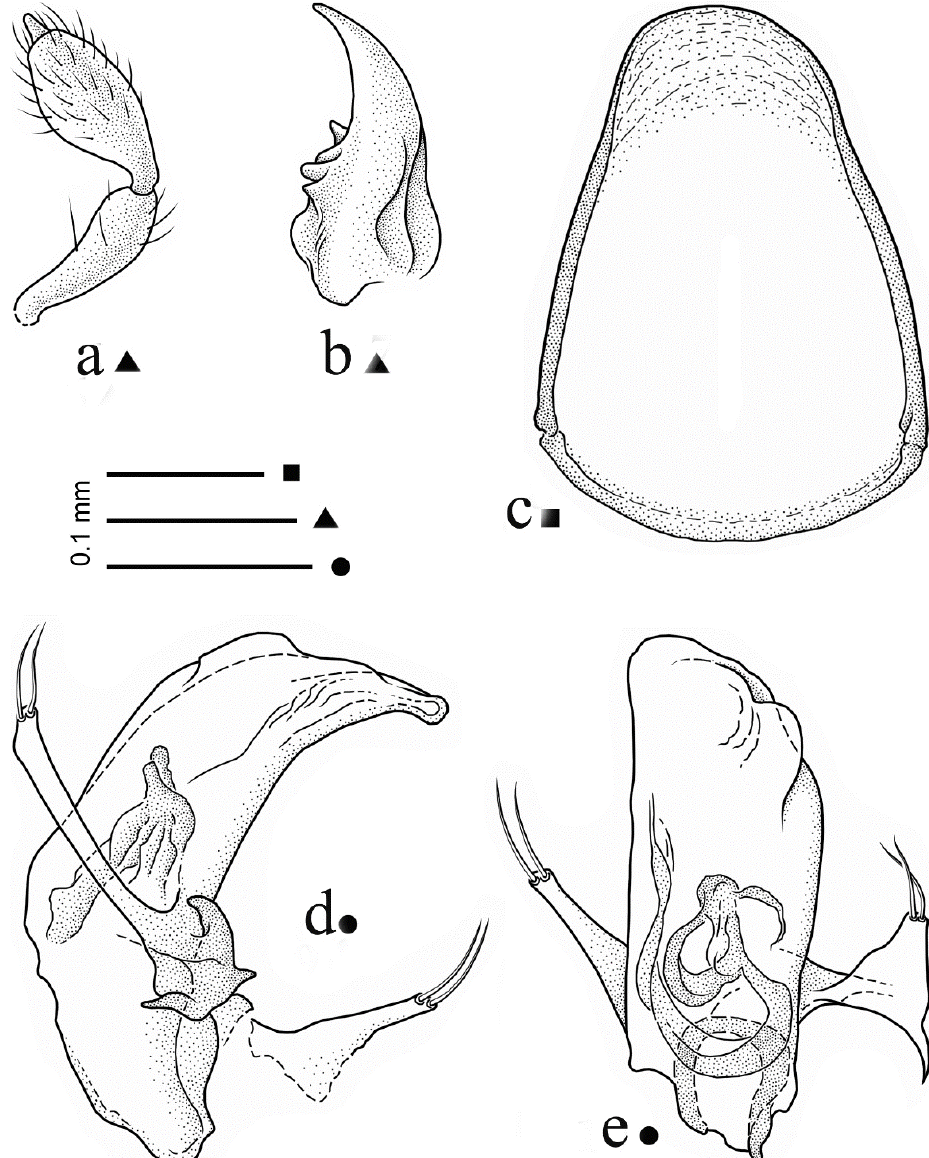
Figure 2. Iason assingi n. sp. HT ♂ . a: right maxillary palp; b: right mandible; c: IX invaginated . a: right maxillary palp; b: right mandible; c: IX invaginated segment; d: aedeagus in lateral view; e: aedeagus in dorsal view. ♂ segment; d: aedeagus in lateral view; e: aedeagus in dorsal